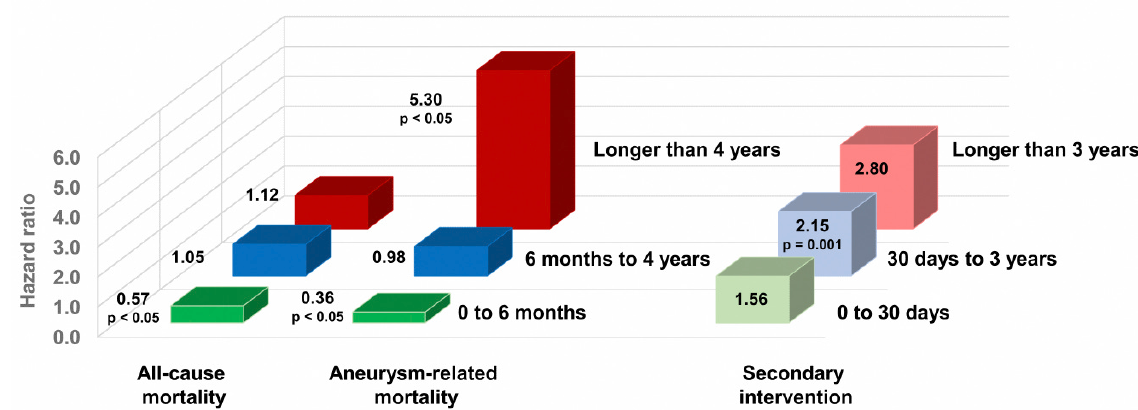
Figure 3. Hazard ratios for endovascular aortic aneurysm repair versus open repair in a meta-analysis of pooled individual patient data from the EVAR-1, DREAM, OVER, and ACE trials 45 . EVAR had a survival advantage at 6 months because of a lower 30-day mortality rate, followed by a gradually higher incidence of aneurysm-related deaths or re-interventions. ACE, Anevrysme de l’aorte abdominale: Chirurgie versus Endoprothese trial; DREAM, Dutch Randomized Endovascular Aneurysm Management trial; EVAR, endovascular aneurysm repair; OVER, Open Versus Endovascular Repair